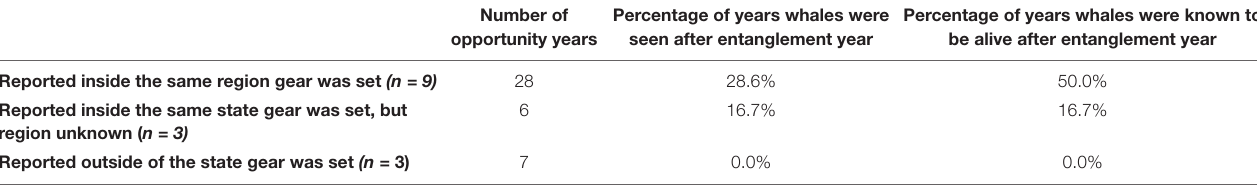
Number of Percentage of years whales were Percentage of years whales were known to opportunity years seen after entanglement year be alive after entanglement year